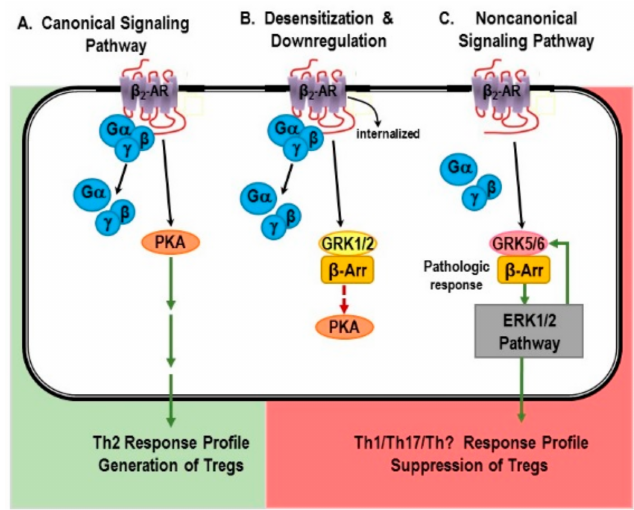
Figure 3. Normal β 2 -adrenergic receptor ( β 2 -AR) signal transduction via G-coupled proteins (canonical), β 2 -AR desensitization and downregulation, and alternative signal transduction mediated by β -arrestin ( β -Arr) are shown in ( A – C ), respectively. ( A ) The Canonical pathway: Ligand binding to the β 2 -AR causes dissociation of G-protein to G α and G βγ and activation of protein kinase A (PKA). Traditionally, activation of this signaling pathway promotes a Th2-type immune response and an increase in Treg cell function that promotes immune response resolution and suppression of inflammation. ( B ) Desensitization and Downregulation: Chronically high SNA in the spleen desensitizes and down-regulates β 2 -AR via G protein-coupled receptor kinase (GRK)1/2/ β -arrestin ( β -Arr) signal transduction that inhibits the p38MAPK pathway, ERK1/2, which prevents PKA activity. ( C ) The activation of the non-canonical β 2 -AR signaling pathway is mediated by a non-G protein mechanism (G protein is uncoupled to the receptor). Instead, GRK5/ β -arrestin ( β -Arr) signal transduction activates the ERK1/2 signaling pathways. The consequences for these two signaling pathways for immune responses in the spleen are indicated below. Signal transduction by the PKA pathway promotes a Th2-type immune response and the generation of Treg cells. In contrast, β 2 -AR signaling via the ERK1/2 pathway drives Th1 and/or Th17 immune responses depending on the immune stimulus, and suppression of Treg cell